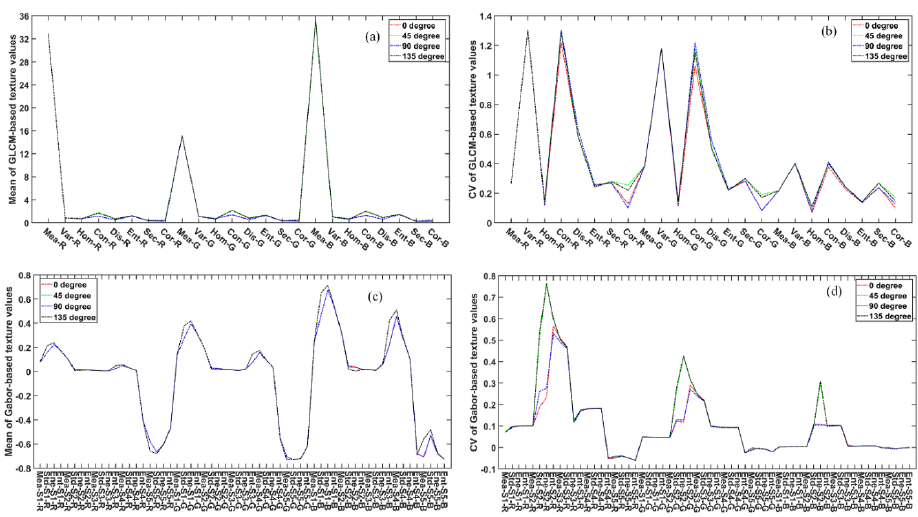
Figure 7. The curves of the mean and coefficient of variation (CV) for ( c , d ) Gabor- and ( a , b ) gray level co-occurrence matrix (GLCM)-based textures of four orientations. Remote Sens. 2020 , 12 , x FOR PEER REVIEW